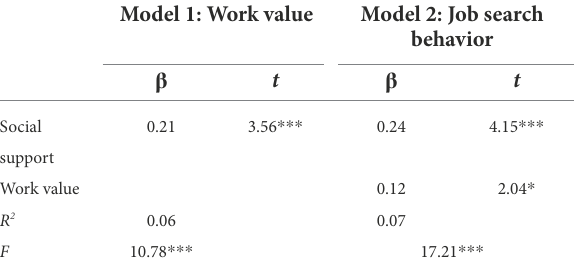
TABLE 2 Summary table of mediation effect analysis. Model 1: Work value Model 2: Job search behavior